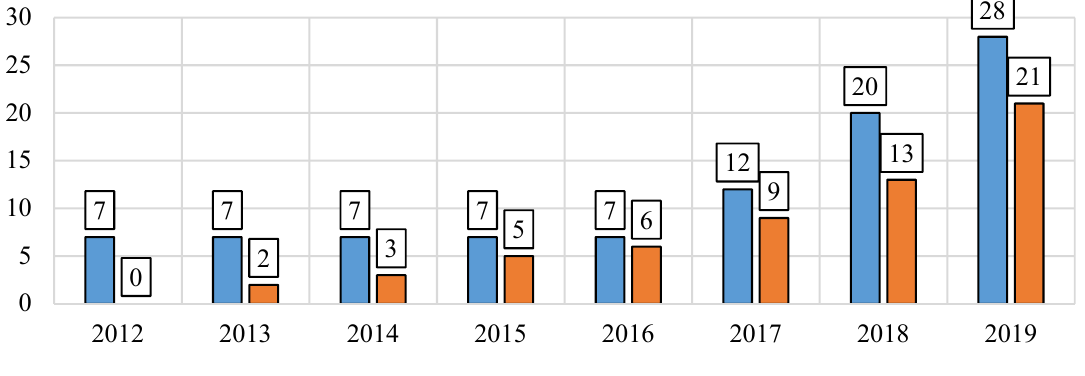
Figure 1. Dynamics of growth in the number of biogas plants in Ukraine, 2012–2019, in units. Source: own